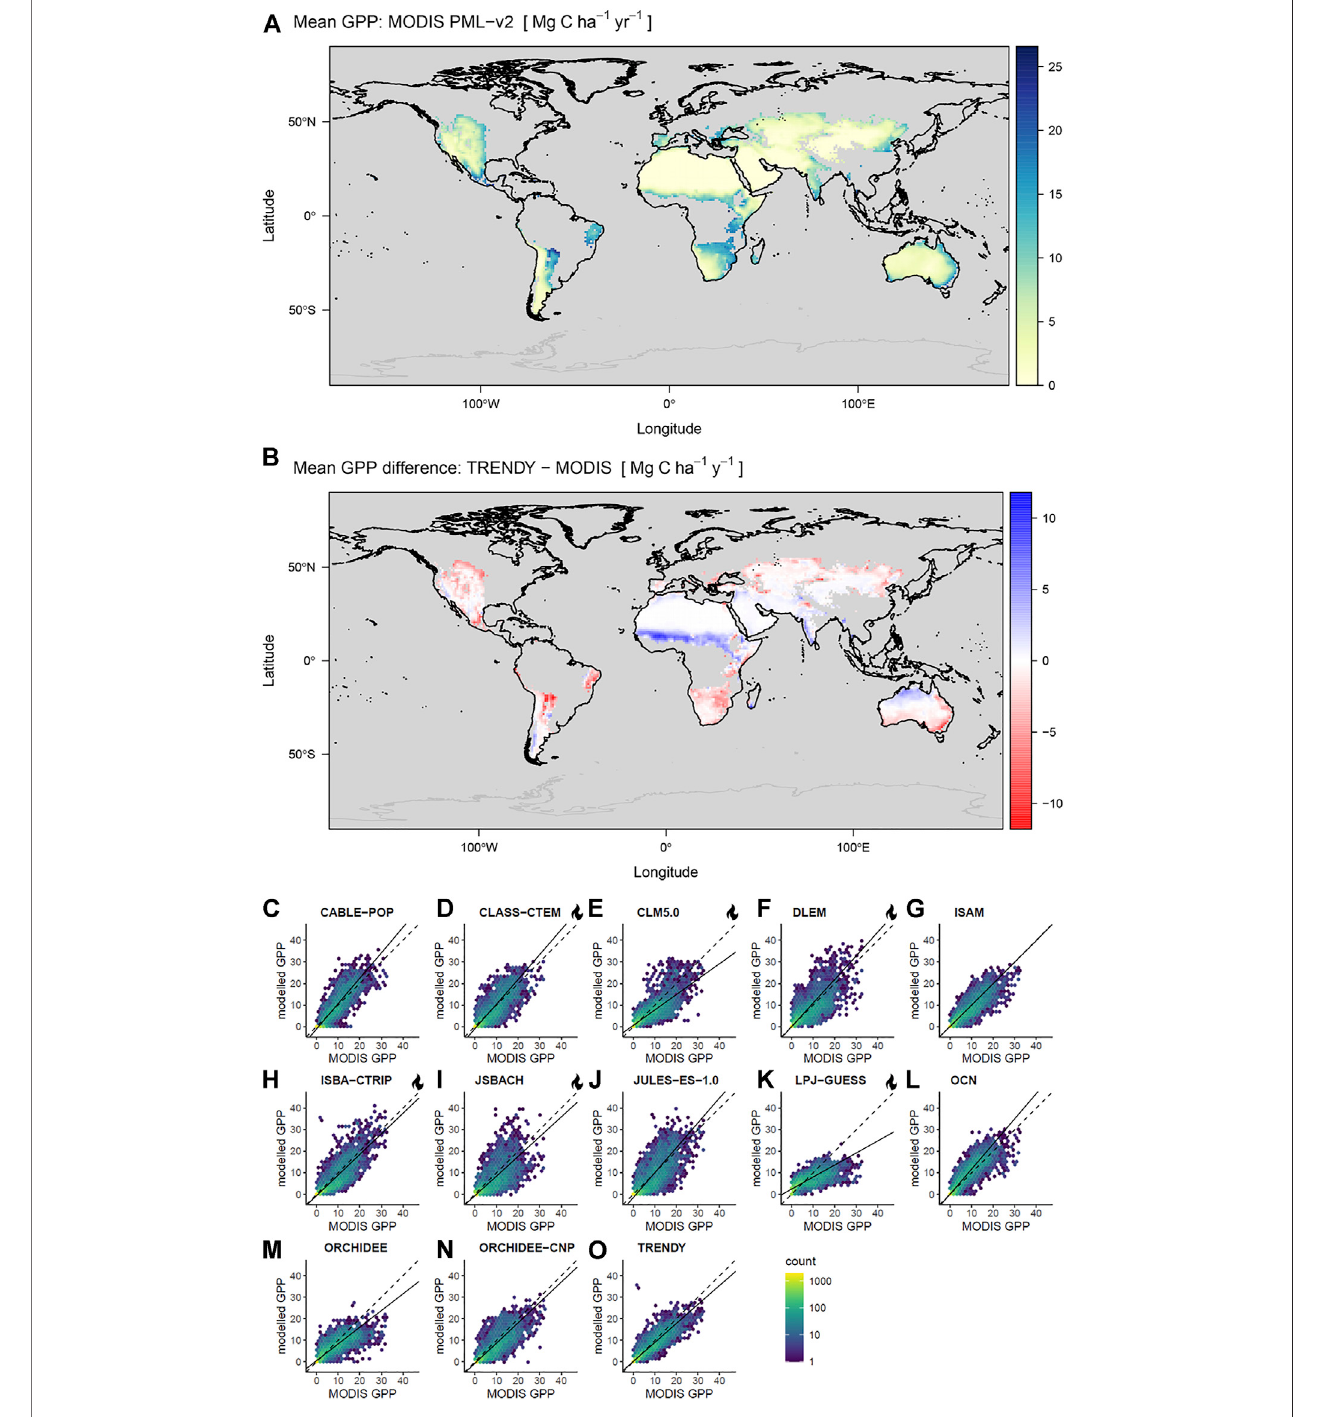
FIGURE 2 | (A) Mean productivity retrieved from MODIS PML-v2, (B) difference between MODIS PML-v2 minus TRENDY-mean productivity over arid and semi- arid regions. The regions analysed are shown in bold. (C – O) Pairwise pixel covariance in annual GPP means over global dryland regions (2001 – 2018) estimated from MODISPML-v2andTRENDYmodels,displayedascountsperhexagonalbin.Dashedlinesrepresent1:1,andsolidlinesarelinearmodels fi ttedwithtotalleastsquares. Units are GPP (Mg C ha − 1 y − 1 ) and all means are calculated over the common 2001 – 2018 time period. Note that in (C – O) models are fi tted to weighted values but weights are not illustrated while (A,B) include only grid cells with centroids within the dryland mask. LSMs with explicit representation of fi re are indicated with a fl ame icon.